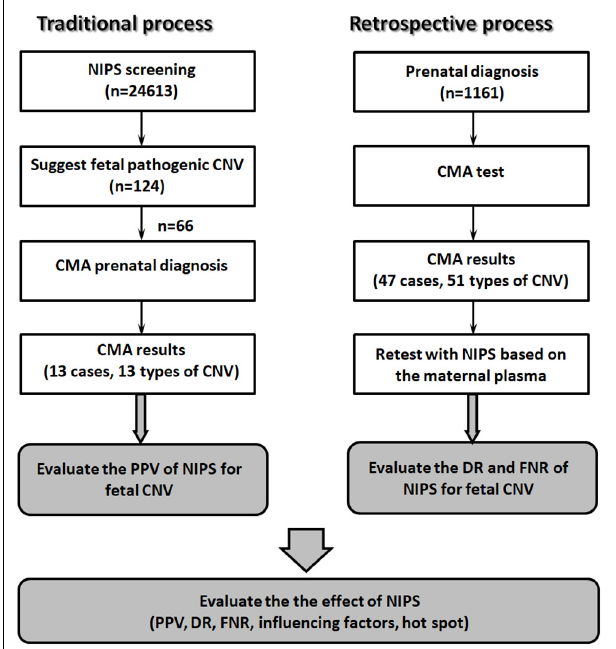
FIGURE 1 | Schematic of the study